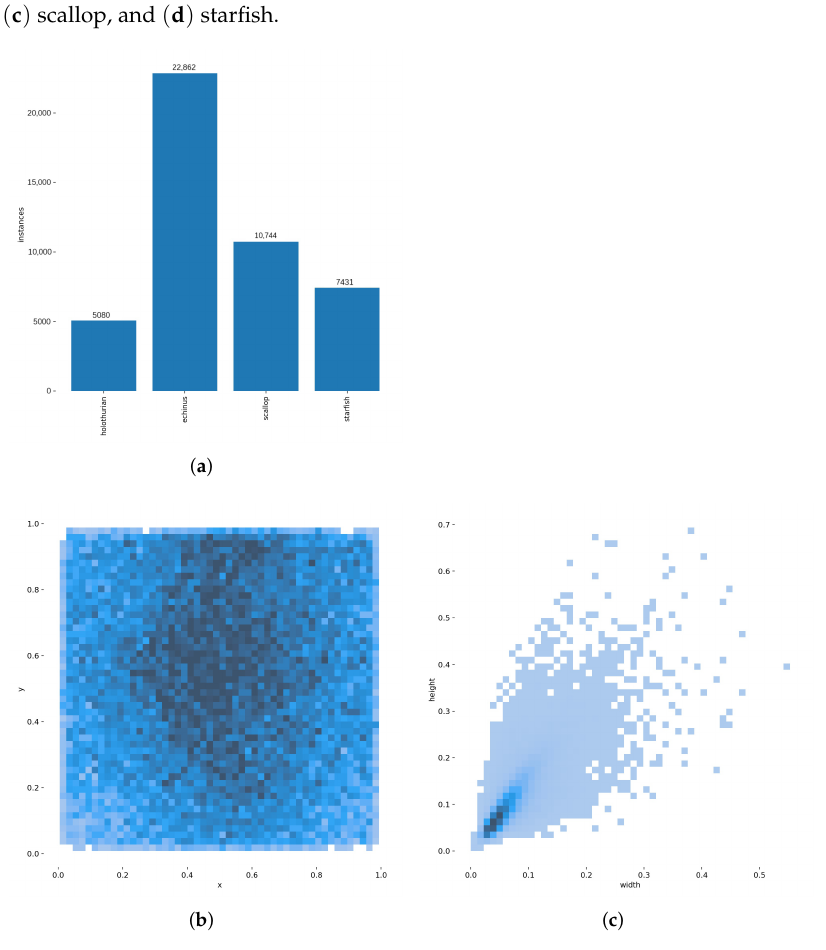
Figure 9. Statistical results of the dataset: ( a ) bar chart of the number of targets in each class; ( b ) normalized target location map; ( c ) normalized target size